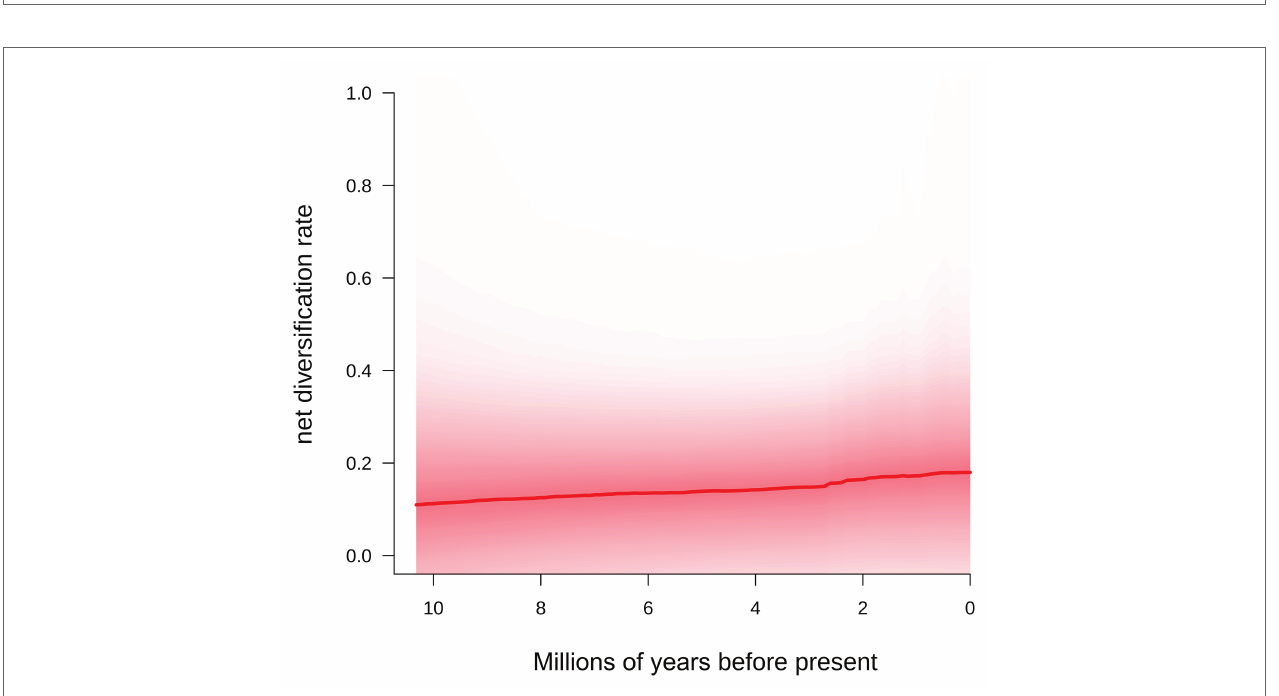
FIGURE 4 | Diversification rate from the origin of the genus Centaurium to the present obtained using BAMM (Rabosky et al., 2013, 2014a; Shi and Rabosky,